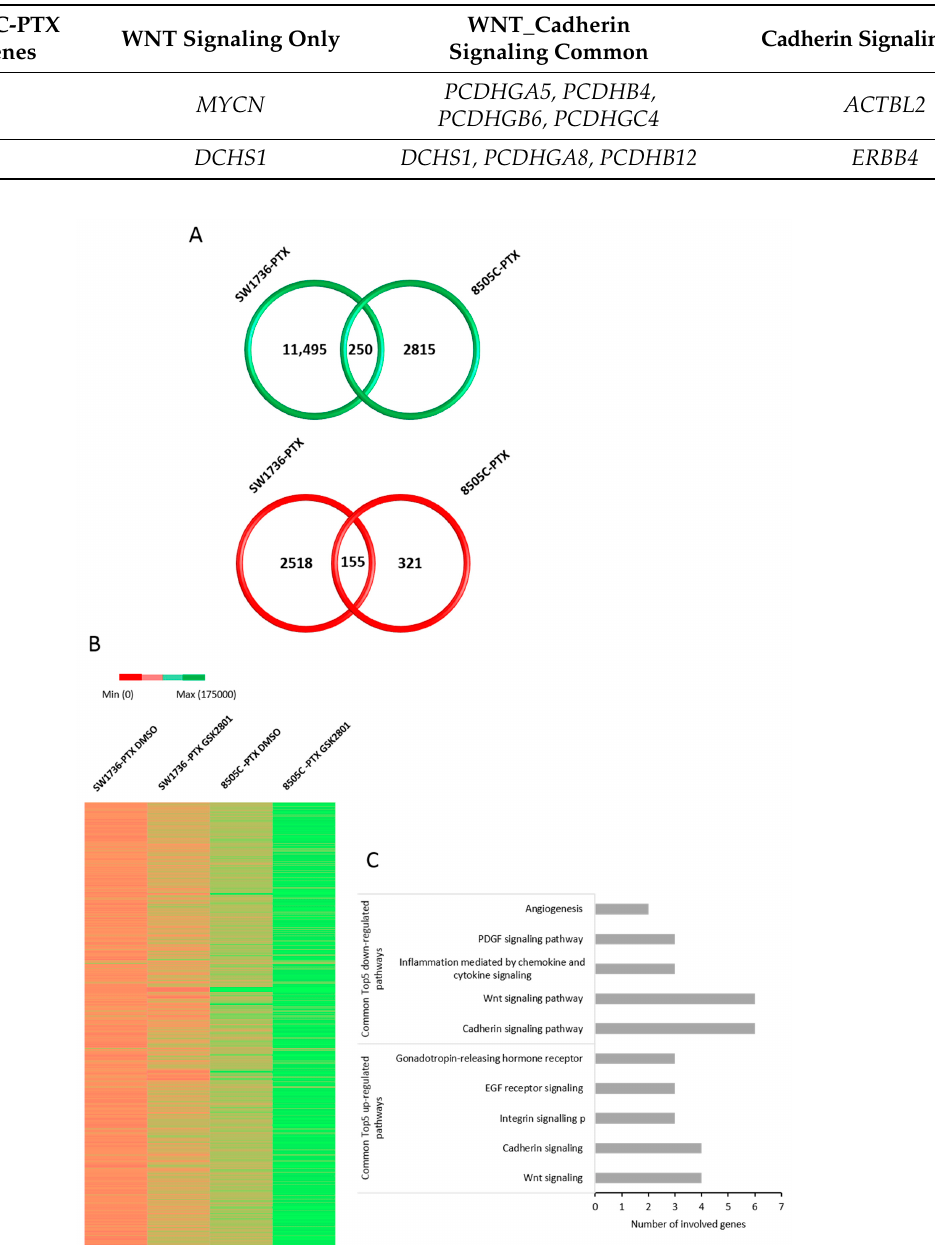
Figure 5. Effects of GSK2801 on gene expression. Venn diagrams represented the comparison of upregulated (green) and downregulated (red) between SW1736-PTX and 8505C-PTX cell lines treated with 20 μ M GSK2801, after RNA-seq data analysis. Within the intersection of the circles are indicated the shared modified genes between the two cell lines (panel A ). Panel ( B ): heat maps obtained after gene expression analysis following treatment with GSK2801 (SW1736-PTX GSK2801 and 8505C-PTX GSK2801) or with the vehicle alone (SW1736-PTX DMSO and 8505C-PTX DMSO) in ATC cells. Panel ( C ): top5 down- and upregulated pathways common in the two cell lines after GSK2801 treatment (20 µ M for 6